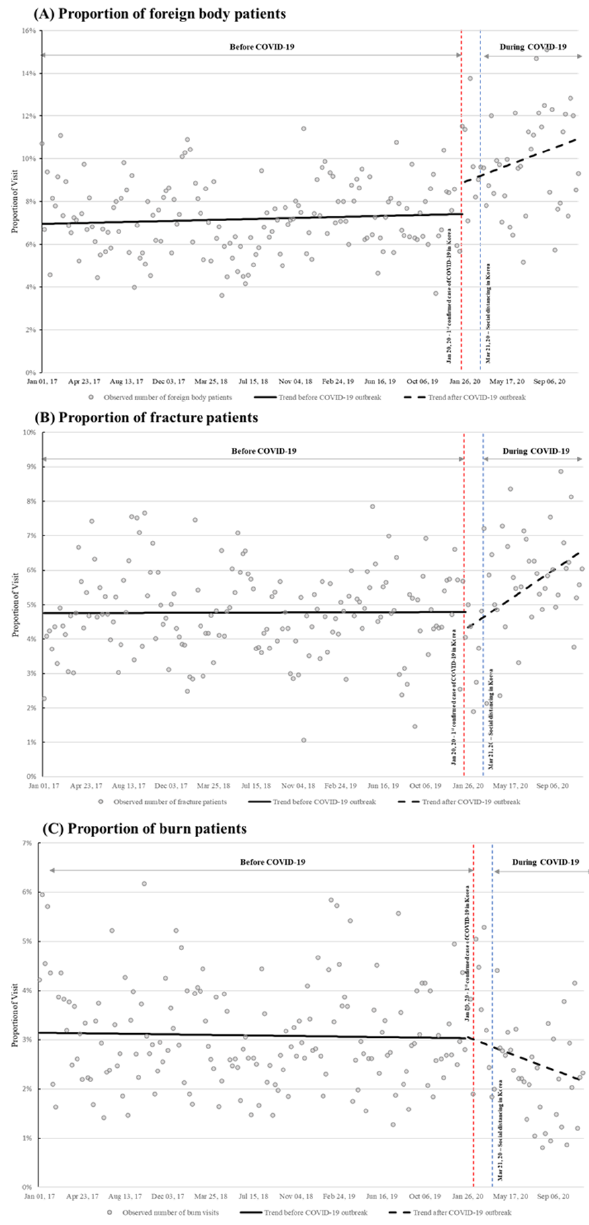
Figure 3. Segmented regression analysis of the weekly proportion of subgroups of injury-related visits. ( A ) Foreign body ingestion, ( B ) fractures, and ( C ) burns. Compared to before the COVID-19 pandemic, the proportion of foreign body ingestion and fracture patient visits significantly increased ( p < 0.05, p < 0.001, respectively). The changes in the proportion of burn patients before and after COVID-19 was not statistically significant ( p = 0.06); COVID-19: coronavirus disease, PED: pediatric emergency